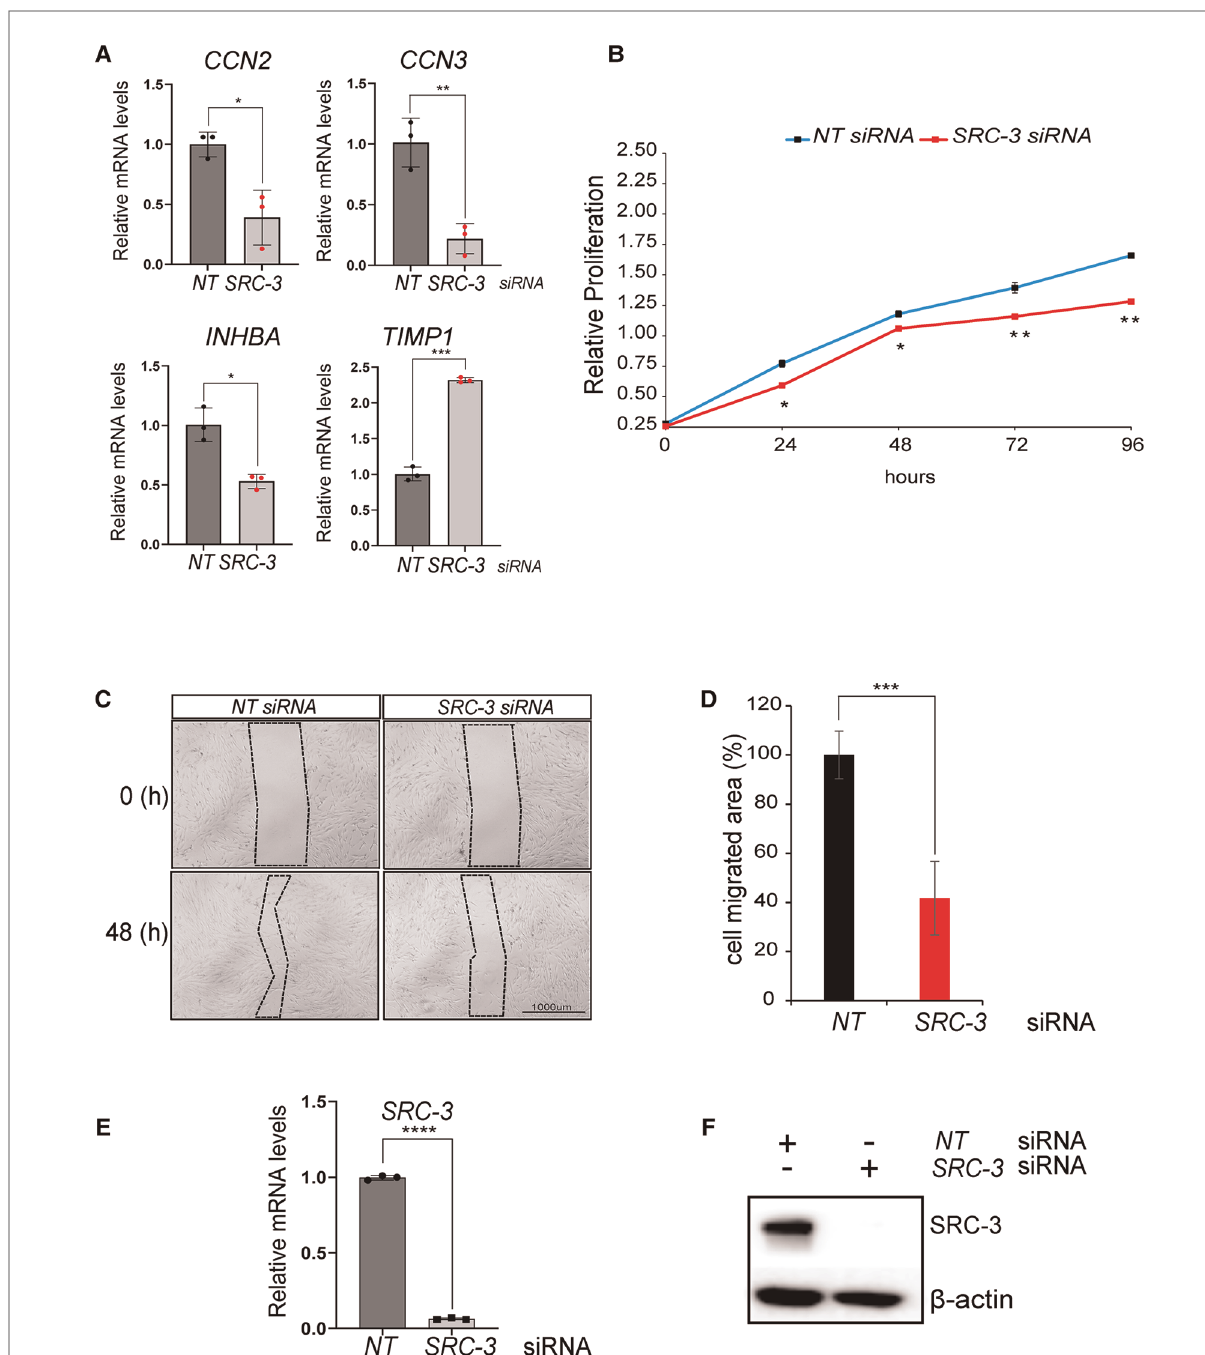
FIGURE 7 Proliferative and migratory properties of T-HESCs are signi fi cantly reduced following SRC-3 knockdown. ( A ) Quantitative real-time PCR analyses shows a signi fi cant reduction in the induction of CCN2 , CCN3 , INHBA , and TIMP1 following SRC-3 knockdown. ( B ) The MTT assay demonstrates that depletion of SRC-3 levels in T-HESCs markedly reduces this cell type ’ s ability to maintain optimum cell viability/ proliferative capacity over time. ( C ) The wound healing assay demonstrated that SRC-3 knockdown resulted in a signi fi cant reduction in the migratory abilities of T-HESCs. Shown is a representative bright- fi eld image of the migrated area (demarcated by dotted line) forty eight hours following the application of the scratch to the cell monolayer, previously transfected with either NT or SRC-3 siRNAs; scale bar applies to all images. ( D ) The histogram quantitatively displays the reduced migratory ability of T-HESCs following SRC-3 knockdown. Migratory ability of T-HESCs is reduced by at least 50% following SRC-3 knockdown (compare black bar ( NT siRNA) with red bar ( SRC-3 siRNA)). ( E,F ) Quantitative real time PCR and western immunoblot analyses con fi rm ef fi cient SRC-3 knockdown in T-HESCs at the RNA and protein level respectively in these experiments. Results in ( E ) are displayed as±SE and are representative of three independent experiments; *p -value <0.05; **p -value <0.01; *** p -value <0.001; and ****p -value<0.0001. Western in ( F ) is representative of three separate experiments; β -actin was used as a loading